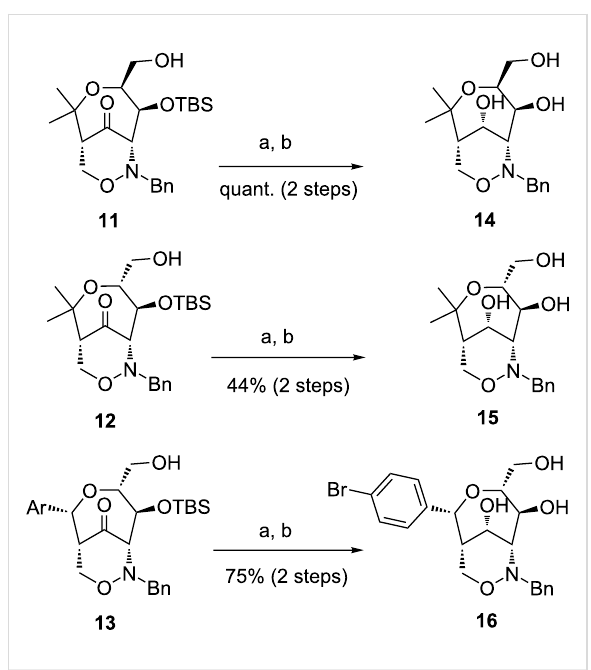
Scheme 6: Synthesis of triols 14 , 15 and 16 by reduction of the car- bonyl group and deprotection. Conditions: a) NaBH 4 , EtOH, 0 °C, 40 min to 16 h; b) TBAF (1 M THF), THF, 0 °C, 10 min to 3.5 h. [TBAF = tetra- n -butylammonium